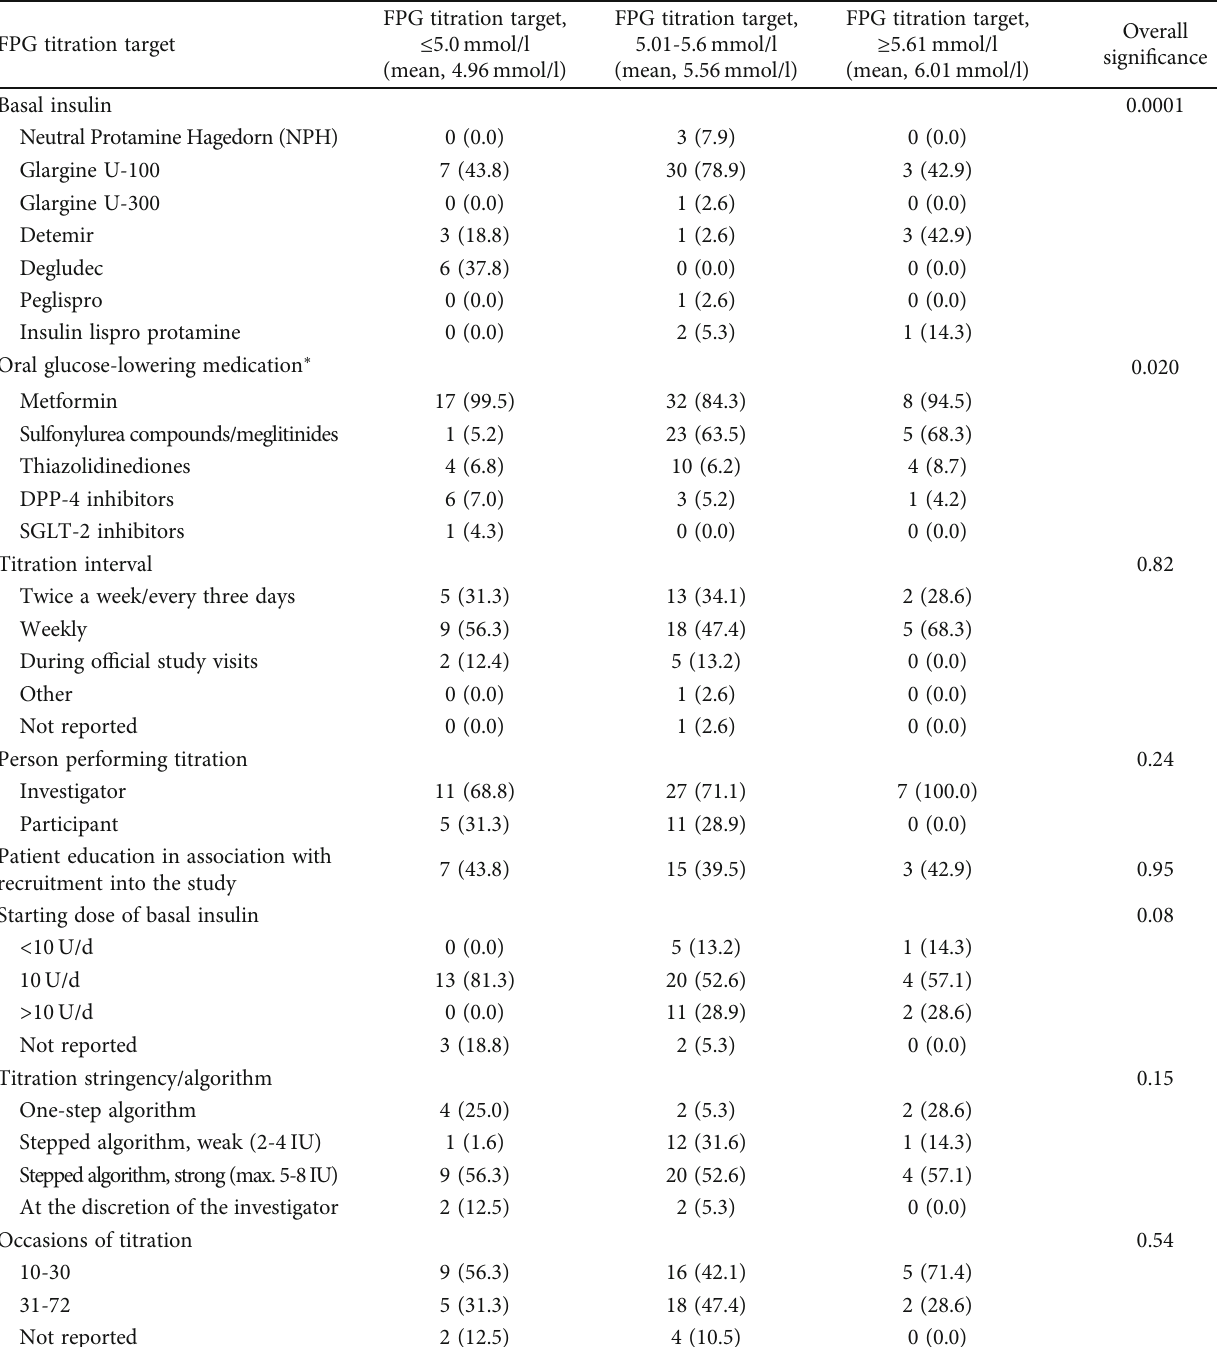
Table 2: Study characteristics by titration target for publications included in the present systematic analysis of insulin-naïve type 2 diabetic patients initiating basal insulin therapy in combination with oral glucose-lowering drugs. Displayed are the numbers of study arms or patients and the proportion (percentage) in this particular subgroup de fi ned by the titration